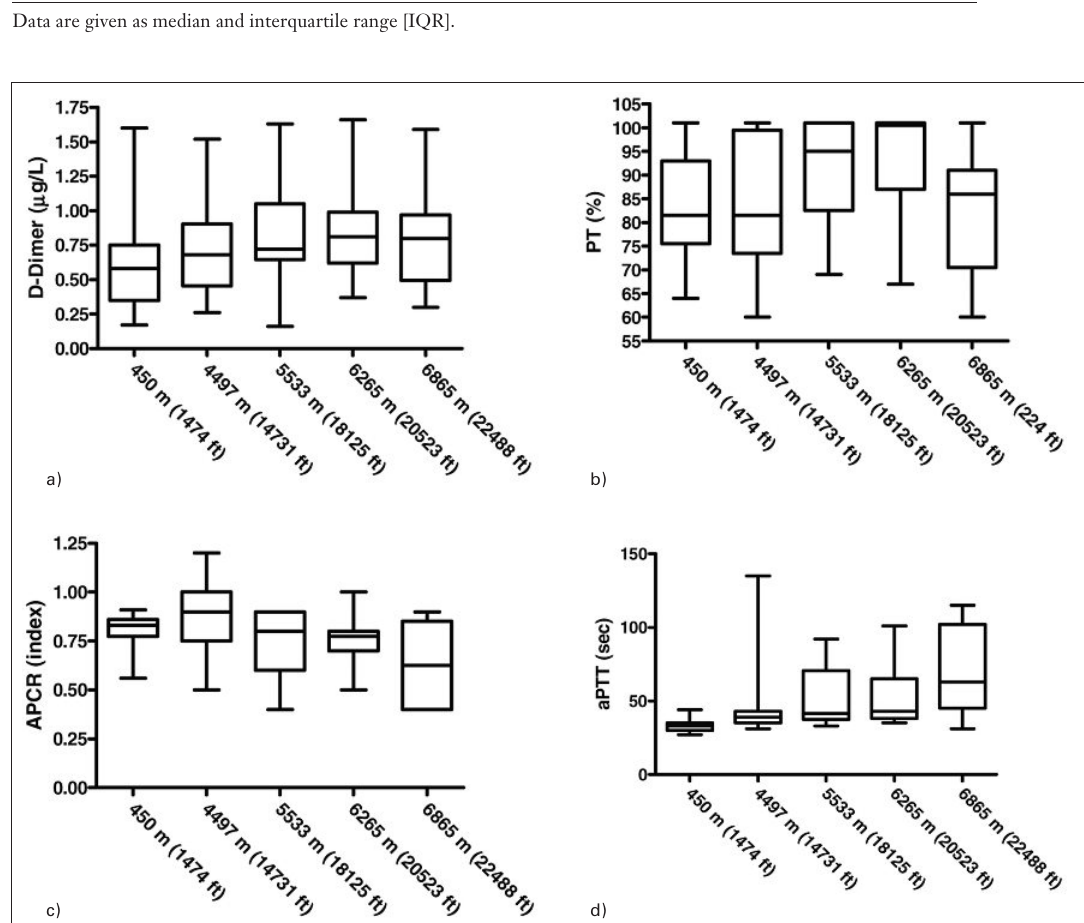
Baseline characteristics of the two groups. All subjects have been checked for throm- bophilia, such as Factor V Leiden Mutation and G20210A prothrombin mutation.Two subjects were found with a heterozygote Faktor V Leiden mutation.